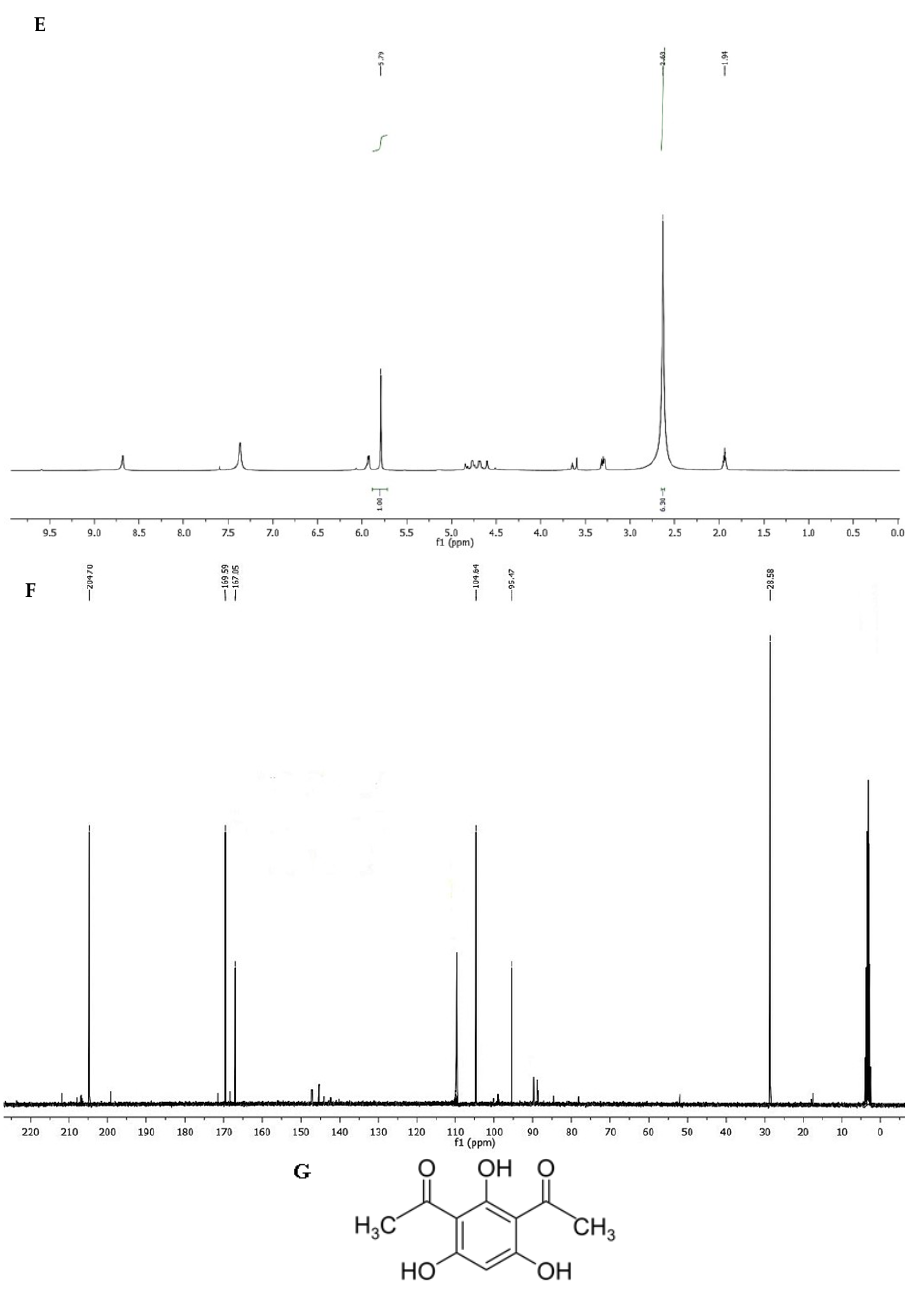
Figure 5. Characterization of 2,4-DAPG metabolites. ( A ) TLC; a: Authentic (Phloroglucinol). b: DAPG, ( B ) UV, ( C ) FT-IR, ( D ) GC-MS, ( E ) 1H, ( F ) 13C NMR and ( G ) structure of DAPG compound.